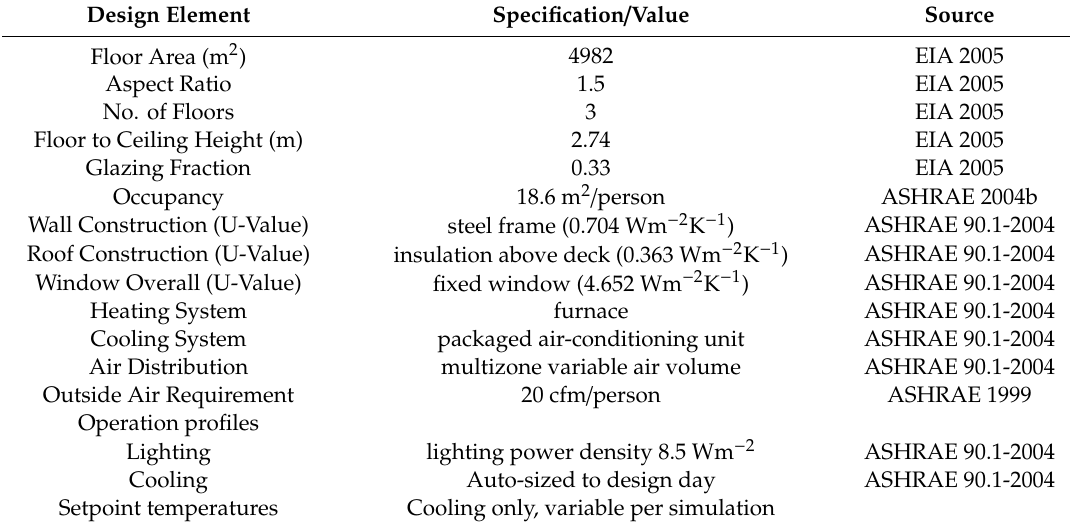
Summary description of key elements of the o ffi ce building in American National Standards Institute (ANSI) / American Society of Heating, Refrigerating and Air-Conditioning